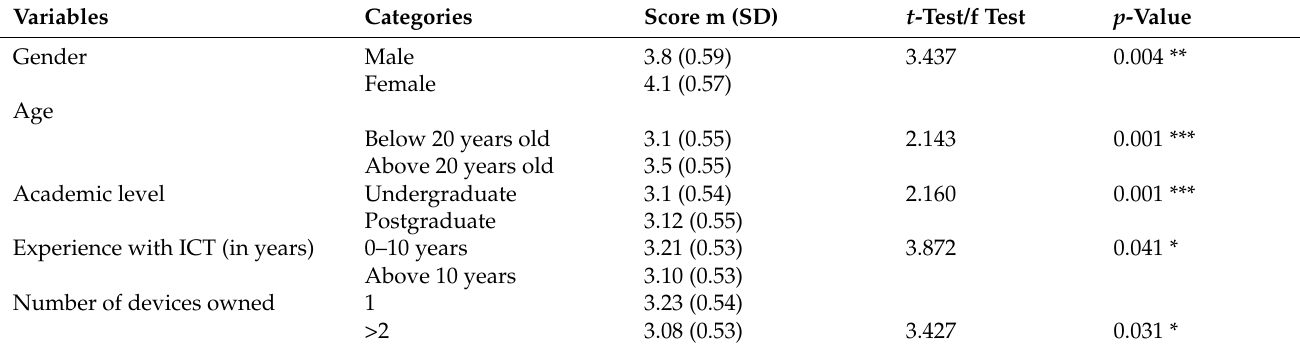
Table 8. Technostress levels and selected sociodemographic